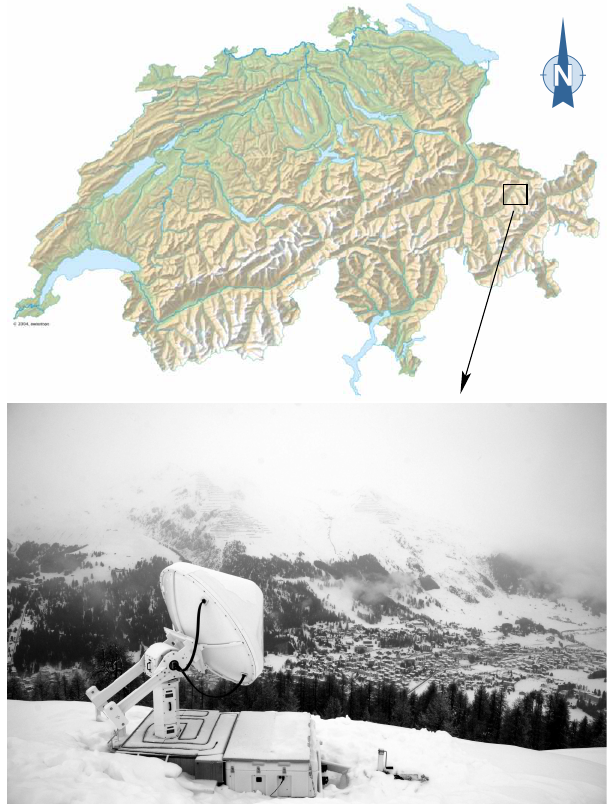
Fig. 4. Radar deployment in Davos (Switzerland). Swisstopo has provided the map of Switzerland in the upper panel.